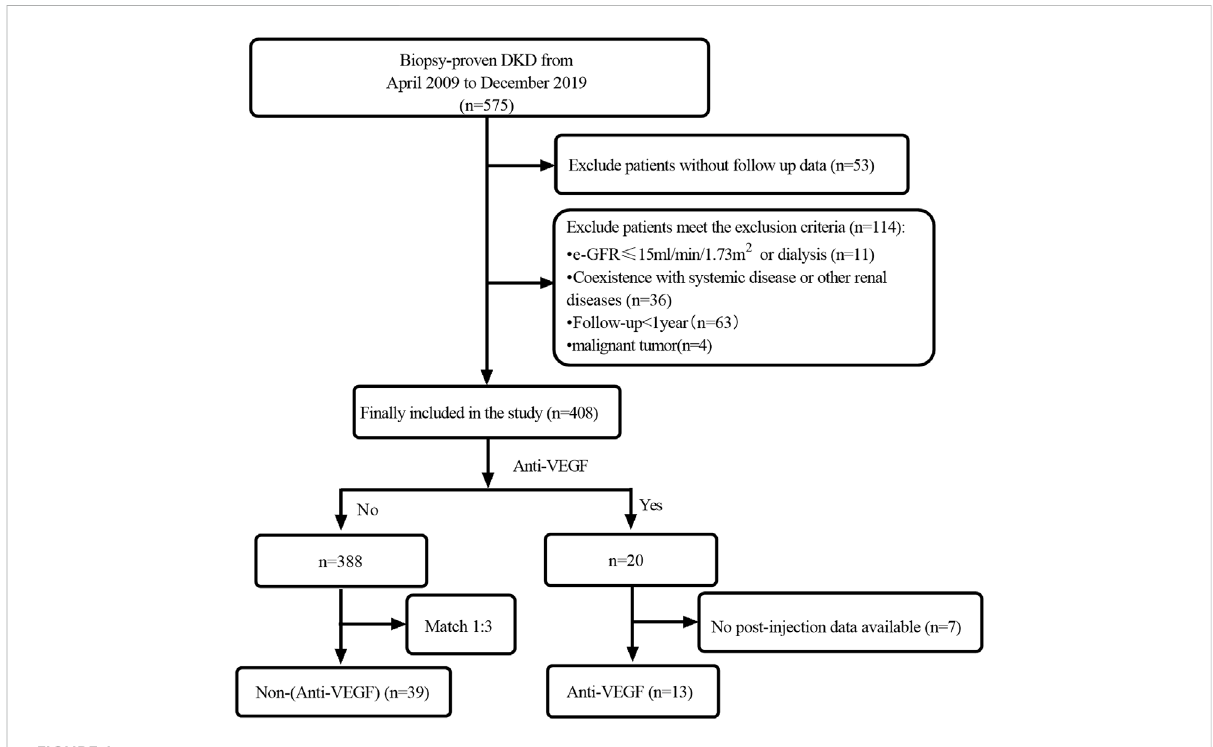
FIGURE 1 Flowchart of study